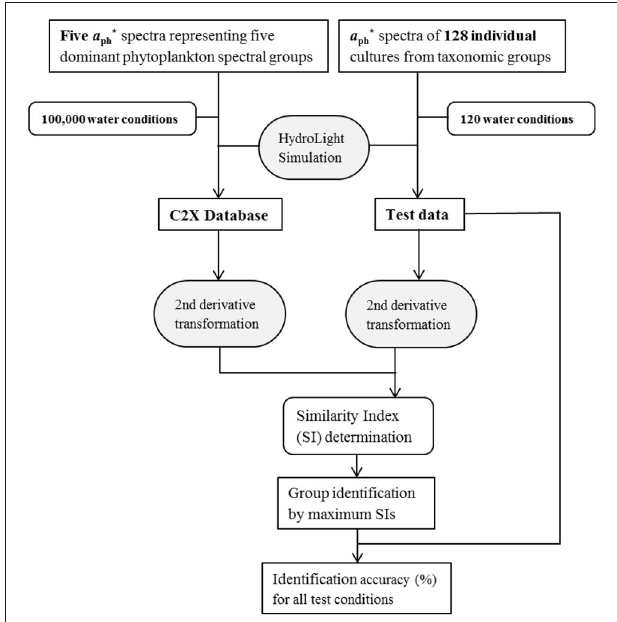
FIGURE 3 | Flowchart showing the approach for dominant phytoplankton group